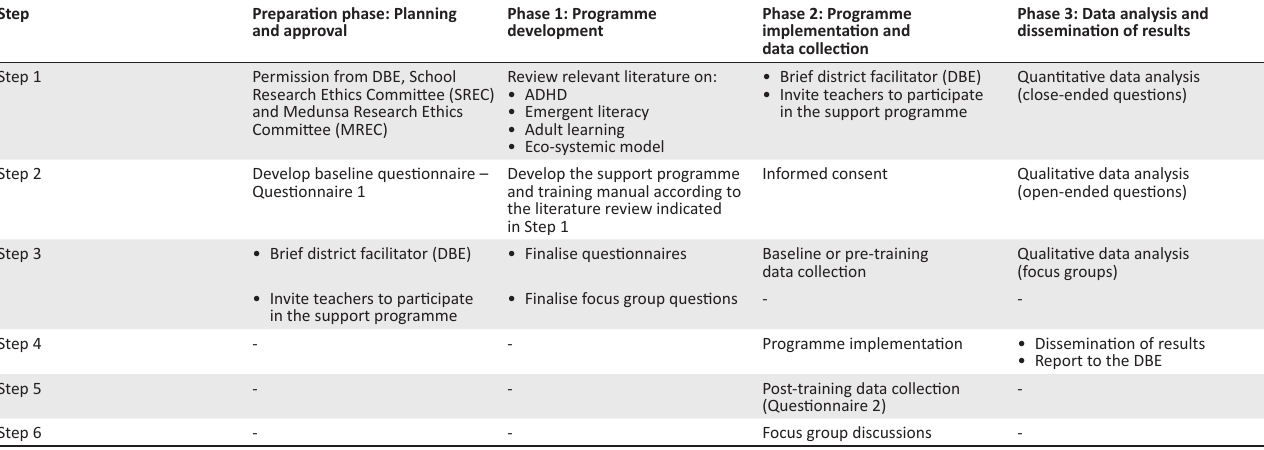
TABLE 1: Research process: Phases of the